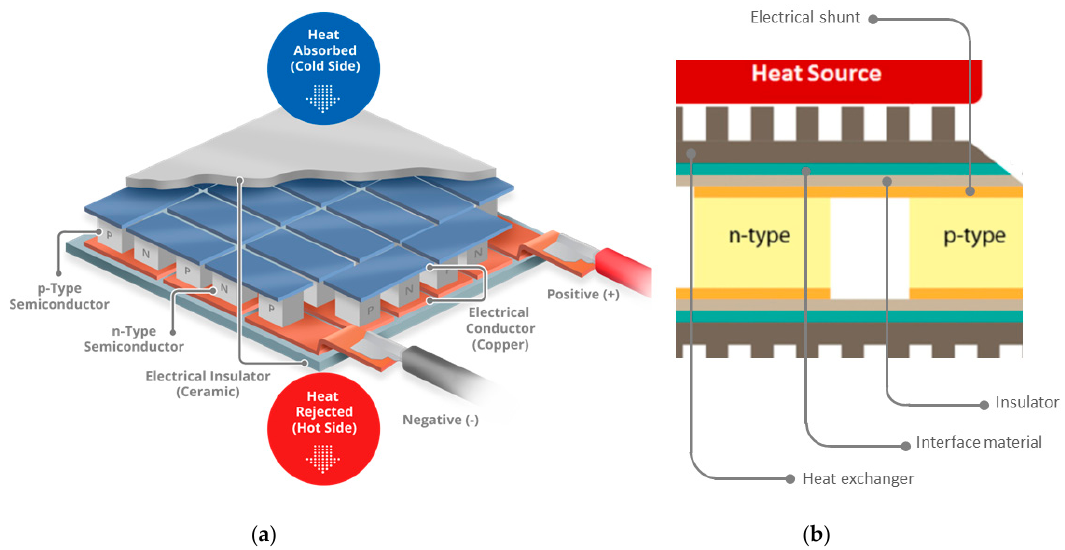
Figure 1. ( a ) Working principle of TEG and TEC; ( b ) components of a typical thermoelectric generator.